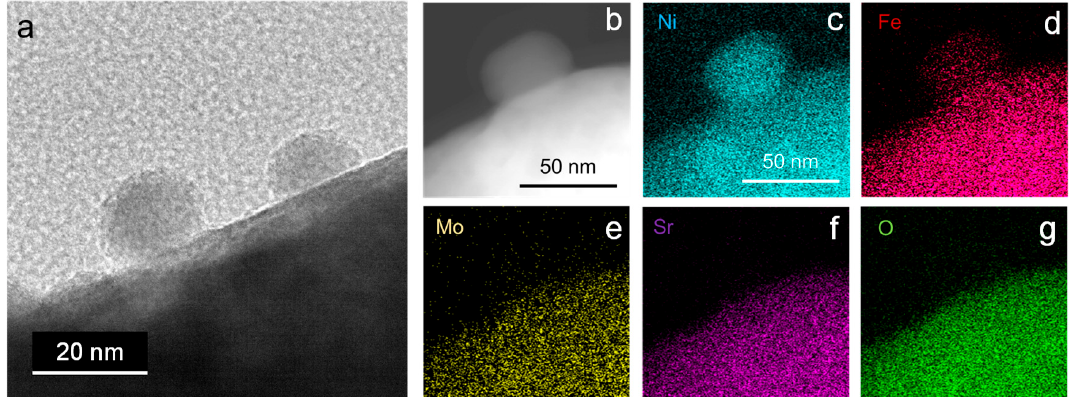
Figure 4. ( a ) TEM image of the SFNM65 material after 2 h exsolution at 900 °C under 5% H 2 , depicting the exsolved nanoparticles. ( b ) HAADF-STEM image of SFNM65 ( c – g ) EDX mapping images for Ni, Fe, Mo, Sr, and O, respectively, showing that the exsolved nanoparticles are just composed by Fe and Ni.